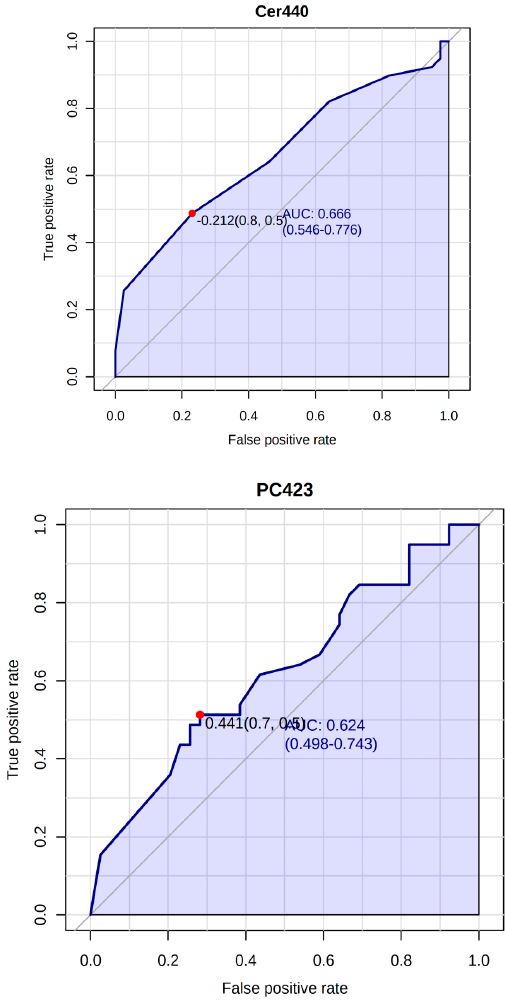
Figure 6. The area-under-the-curve (AUC) of Receiver Operating Characteristic (ROC) analysis showing Cer440 and PC423 specificity and selectivity to distinguish between the study groups.